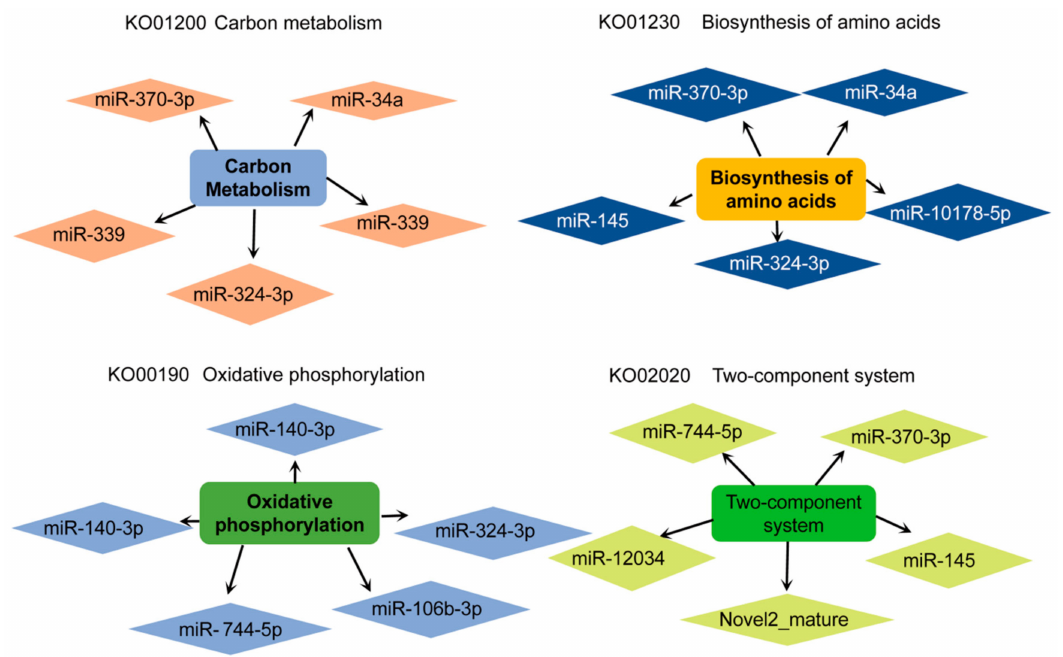
Figure 8. Co-expression networks among the important DEMs and the target mRNAs enriched for signaling pathways in the transformation of vegetative cells into dormant cysts of P. cristata . Diamonds represent the DEMs within each signaling pathway, and round rectangles represent the signaling pathways associated with relative target